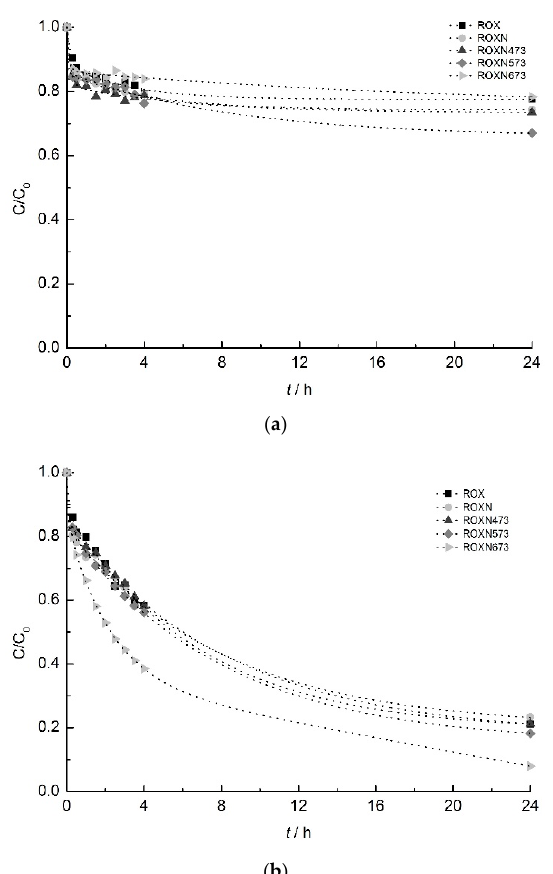
Figure 4. Phenol normalized concentration obtained as a function of time in ( a ) adsorption and ( b ) CWPO runs performed with thermally modified ROX samples. Experiments performed with [phenol] = 4.5 g L − 1 , [adsorbent/catalyst] = 2.5 g L − 1 , T = 353 K, pH = 3.5 and, in CWPO runs, [H 2 O 2 ] = 25 g L − 1 (stoichiometric amount).